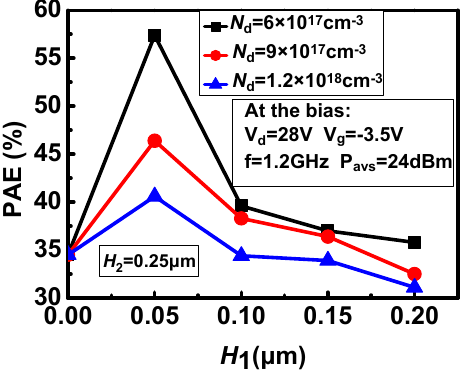
Figure 4. The e ff ects of N d and H 1 on the Figure 4. The effects of N d and H 1 on the PAE.